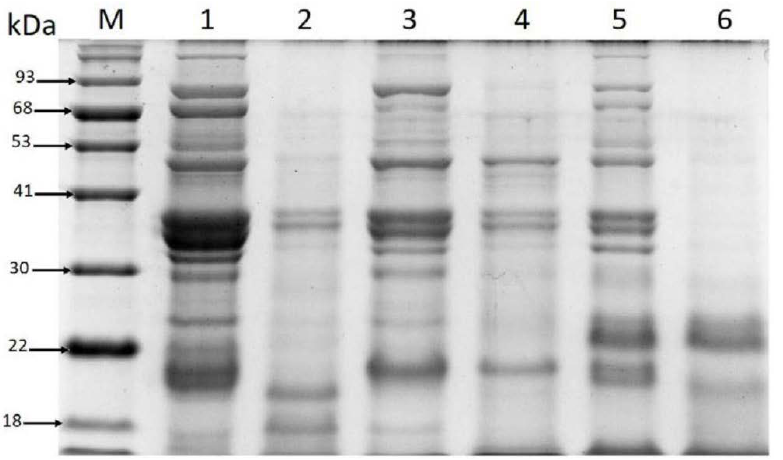
Fig. 4. Comparison of protein profiles in the extracts of the analyzed chickpea beverages Explanatory notes: Chickpea beverage variants: natural without any flavor additives (Lane 1- unfermented, Lane 2- fermented); with soy sauce addition (Lane 3- unfermented, Lane 4- fermented); with addition of vanillin sugar and coconut flakes (Lane 5- unfermented, Lane 6- fermented); Lane M” protein standard